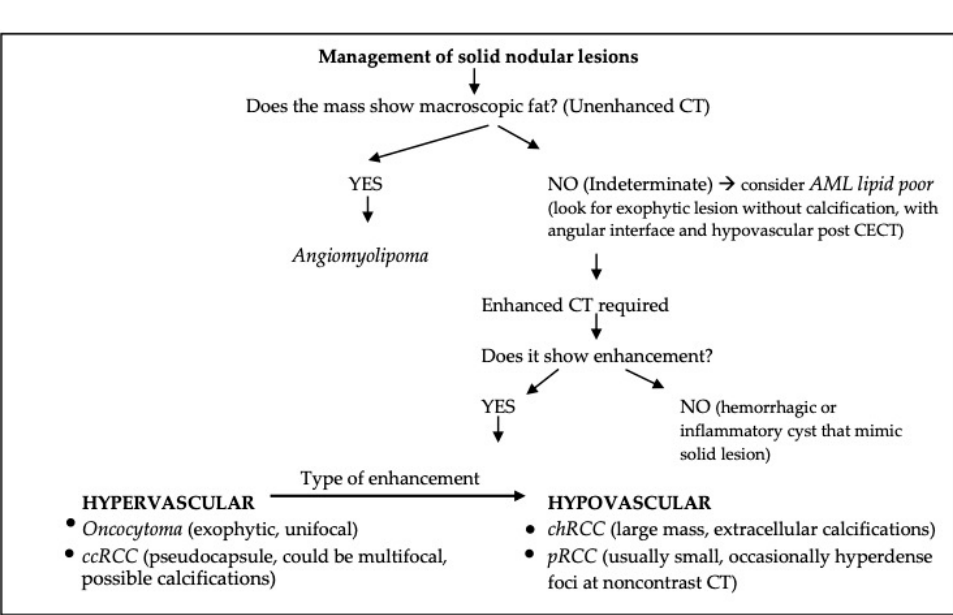
Figure 8. Modified Nicolau et al. algorithm for assessment of SRMs